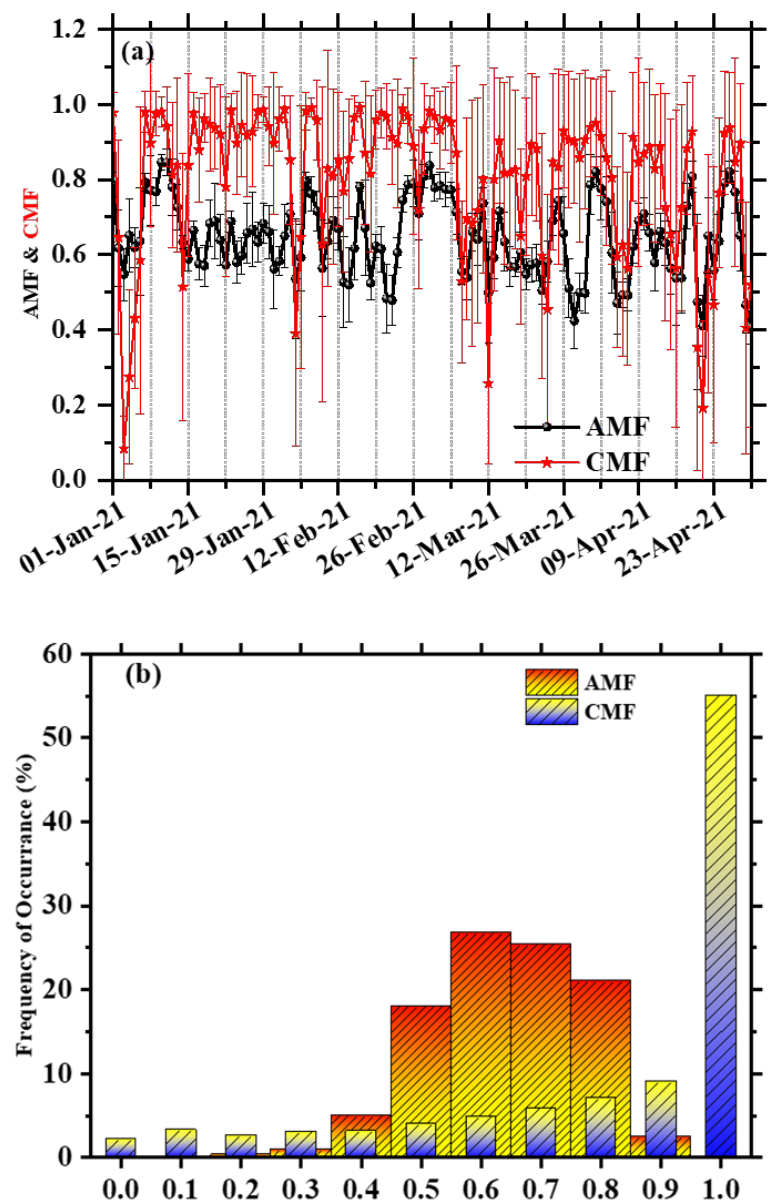
Figure 11. Time-series plots of aerosol modification (AMF) and cloud modification (CMF) fractions during January to April 2021 ( a ), and frequency distribution of AMF and CMF during January to April 2021 (b).